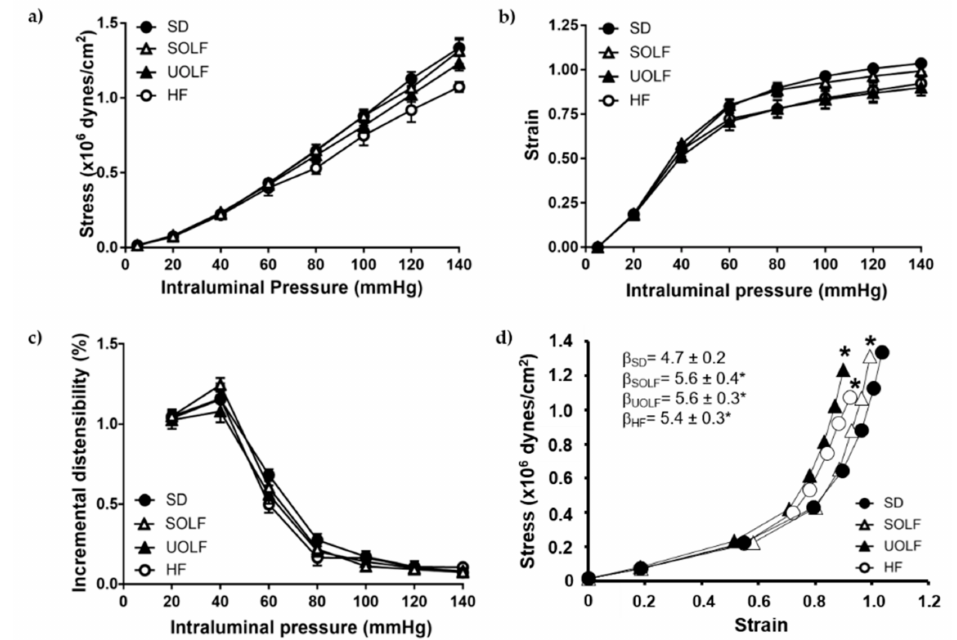
Figure 4. Characterization of mechanical parameters in first-order mesenteric resistance arteries. ( a ) Wall stress-pressure, ( b ) strain-pressure, ( c ) incremental distensibility-pressure curves and ( d ) stress-strain relationships with β values of MRA from SD, UOLF, SOLF, and HF mice. Results are expressed as mean ± SEM of n = 7–10. * p < 0.05 vs. the SD